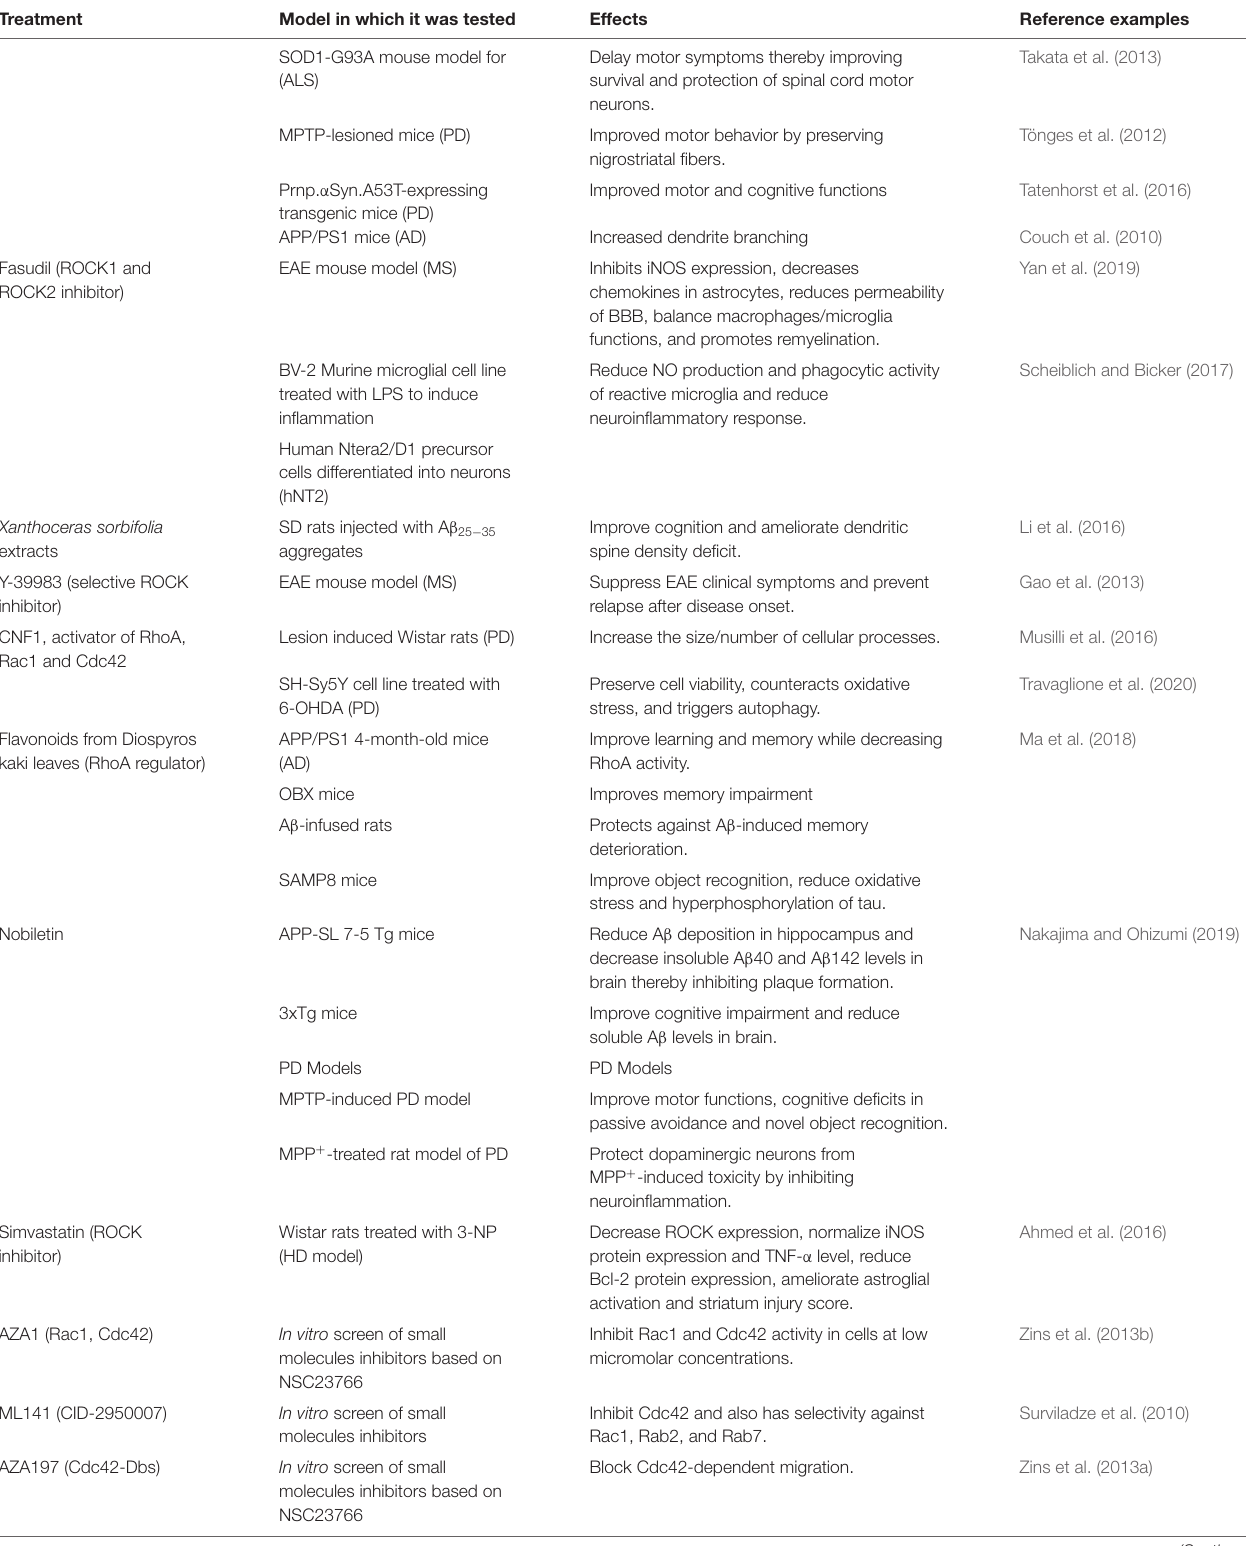
TABLE 1 | Pharmacological modulators of Rho GTPases and their potential applications.